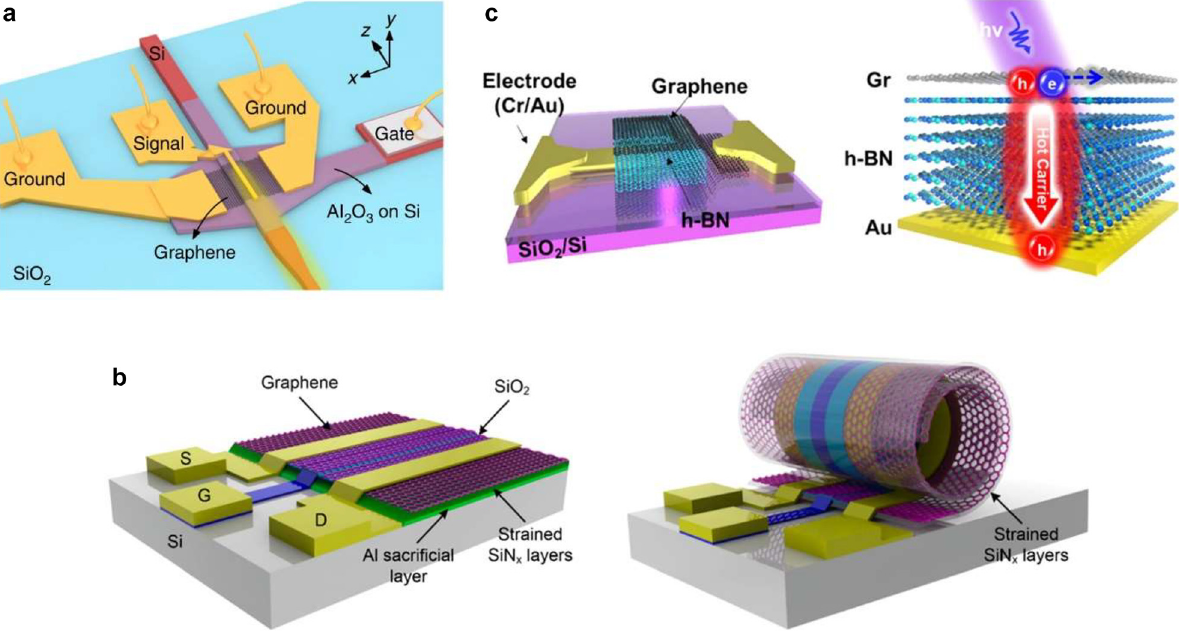
Figure 7: Photodetection applications of graphene. (a) Waveguide integrated graphene photodetector with a narrow plasmonic waveguide for facilitated light absorption in graphene. Adapted with permission from [67]. (b) 3D GFET device before (left) and after (right) roll-up process. 3D photonic nanocavity signi fi cantly enhances light – matter interaction. Adapted with permission from [110]. (c) Schematic of the graphene/h-BN/Au heterostructure photodetector (left) where photoexcited hole-type carriers transport through the h-BN layer either by tunneling or thermal distribution (thermionic) transport (right). Adapted with permission from